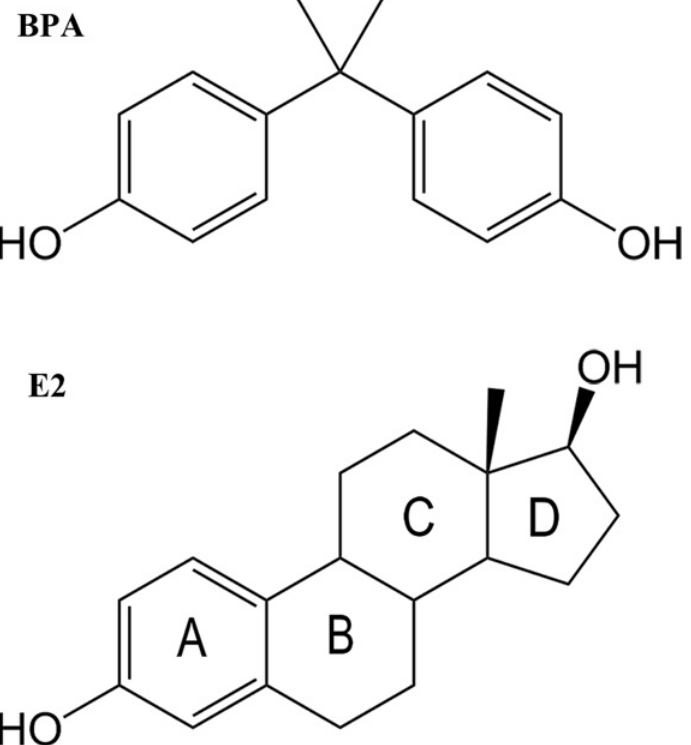
Fig 1. The chemical structure of the ligands. a) bisphenol A; b) 17 β -estradiol